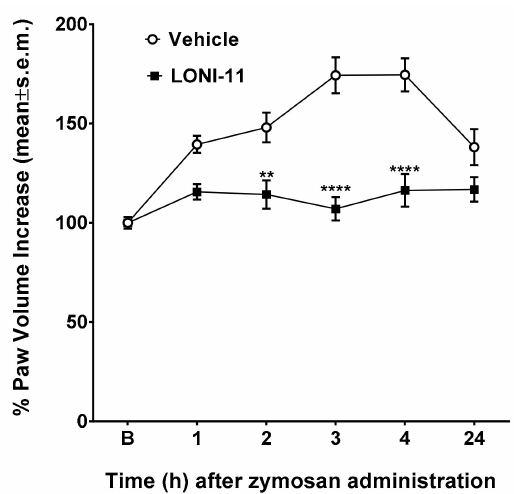
Figure 6. E ff ects of vehicle (V, saline containing 0.9% NaCl in the ratio DMSO:saline 1:3 ( v / v )), and LONI11 on zymosan-induced edema. Zymosan (2.5% w / v in saline, 20 µ L) was subcutaneously administered in the dorsal surface of the right hind paw. Drugs were administered subcutaneously in the dorsal surface of the right hind paw at the dose of 100 µ g / 20 µ L, 15 min before zymosan. Paw volume was measured 1 h before zymosan and 1, 2, 3, 4 and 24 h thereafter. The paw volume increase was evaluated as the percentage between the paw volume at each time-point and the basal paw volume. The results obtained are expressed as the mean ± S.E.M.; ** is for p < 0.01 and **** is for p < 0.0001 vs. V. N = 6.